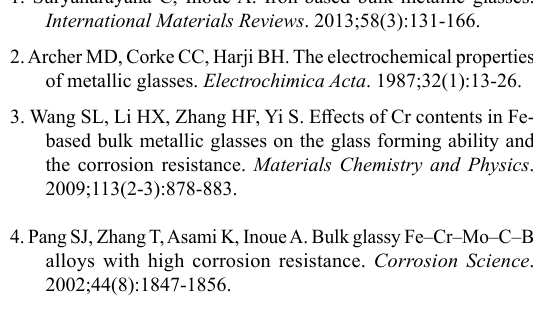
theoretically predicted in this paper (4.35 mm as shown in Table 1) and also lower than that theoretically predicted by Cheney and Vecchio (3.4 mm) 11